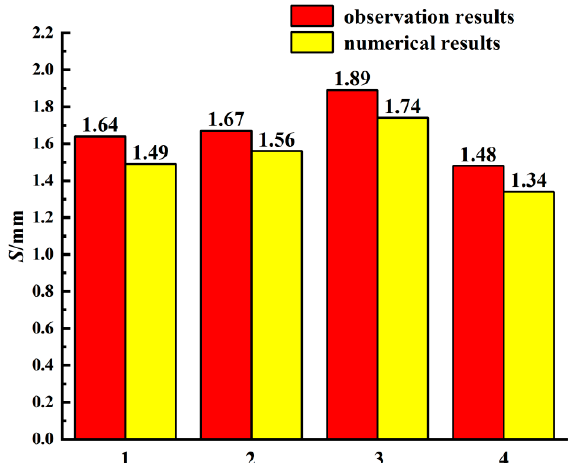
Figure 12. The y-direction displacement contour on the longitudinal section of the tunnel with the real reinforcement method (unit: m).